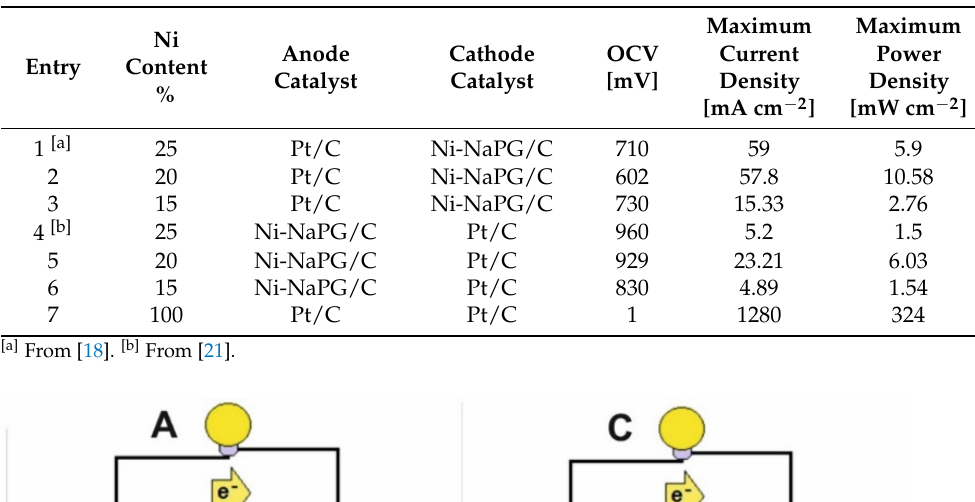
Table 5. Open circuit voltage (OCV), maximum current and power densities generated by the vari- ous PEMFCs based on Ni(n%)-NaPG on carbon black (Vulcan XC-72) and carbon black-supported Pt.